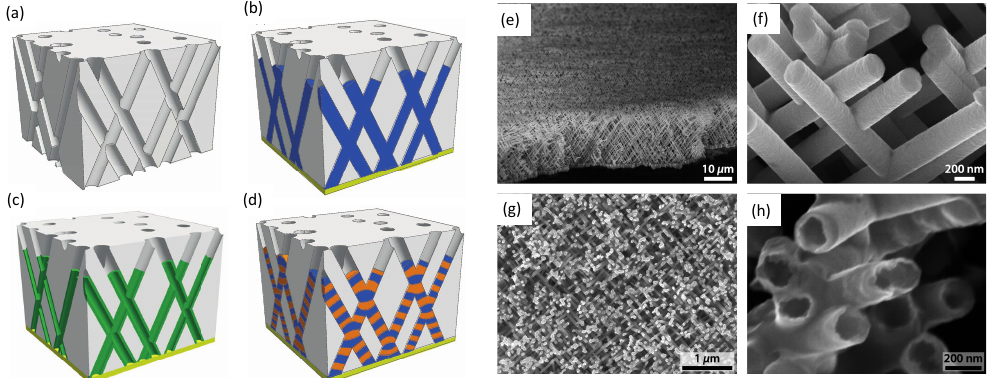
Figure 4. ( a ) schematics of 3D nanoporous polymer template, ( b ) crossed nanowire and ( c ) crossed nanotube networks, and ( d ) crossed multilayered nanowire network; ( e – h ) SEM images of self-supported interconnected nanowire and nanotube networks; ( e , f ) Ni NW network film with 230 nm diameter; ( g ) Ni NW network film with 40 nm diameter; ( h ) Ni crossed nanotube network with 230 nm